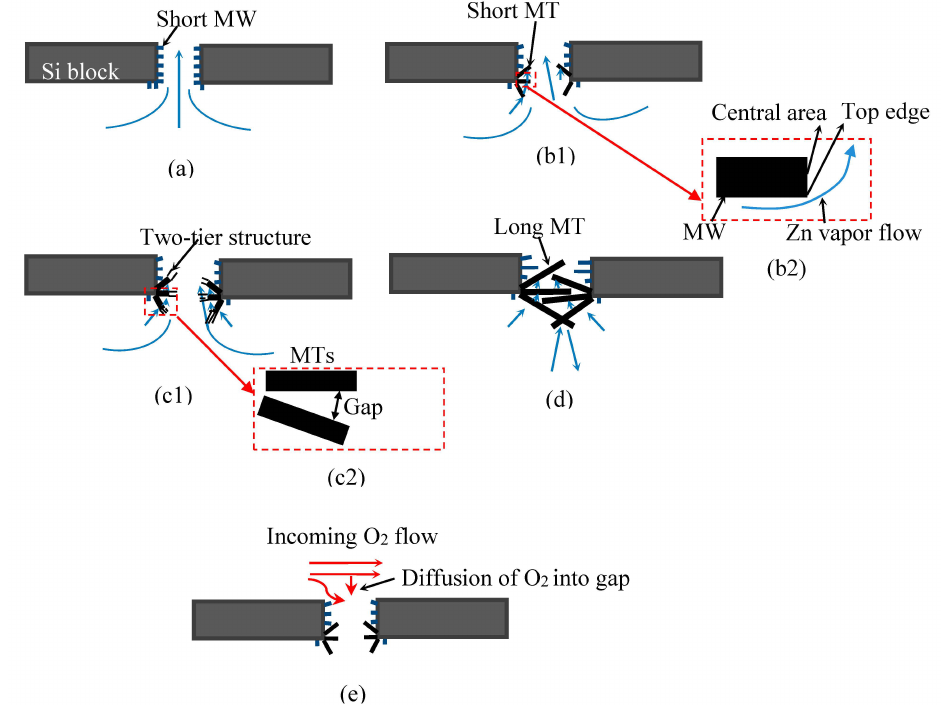
Figure 5. Flow patterns of Zn vapors around ZnO structures in ( a ) first, ( b ) second, ( c ) third, ( d ) fourth steps, and ( e ) diffusion of O 2 gas to the sidewalls of two Si blocks (not to